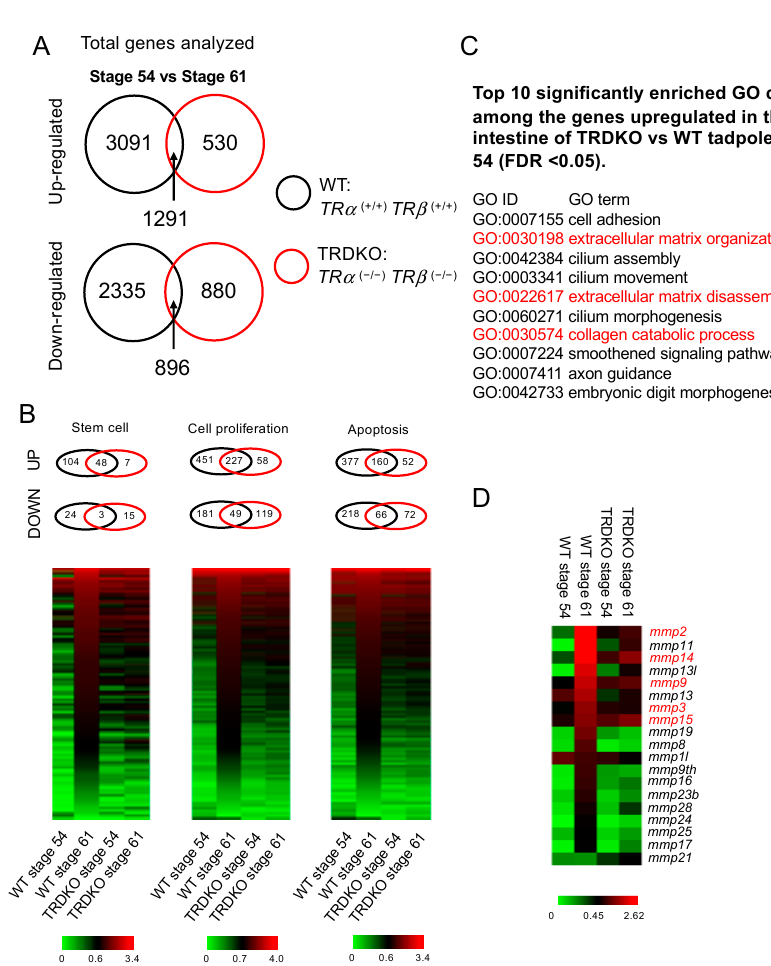
Figure 6. TR double knockout inhibits the upregulation of genes in the GO categories involved in major intestinal remodeling processes: stem cell, cell proliferation, and apoptosis, at stage 61 during metamorphosis, but derepresses genes in ECM remodeling at premetamorphic stage 54. ( A ) Venn diagram analysis of genes regulated during intestinal metamor- phosis in wild-type and TRDKO tadpoles shows that the vast majority of the regulated genes are different between the wild-type and TRDKO animals. RNA-seq was carried out on intestinal RNA from wild-type and TRDKO tadpoles at premetamorphic stage 54 and climax stage 61. Genes up- or down-regulated at stage 61 compared to stage 54 (2 folds or more) were identified for each genotype and compared. Note that there were much fewer genes regulated in the TRDKO animals. ( B ) Venn diagrams and heat maps reveal that TRDKO tadpoles have drastically reduced number of regulated genes at stage 61 in the three GO categories critical for intestinal remodeling: stem cell, cell proliferation, and apoptosis. Top: All genes in each of the three GO categories were identified from the up- and down-regulated genes in each genotype as found in (A) and compared by Venn diagram analysis between the two genotypes. Note that again most of the genes did not overlap between the two genotypes. Bottom: Heat maps of the expression of all genes in each GO category at the two stages for the two genotypes. Note the coordinated upregulation of most of the genes in each GO category at stage 61 compared to stage 54 in the wild-type intestine but not in the TRDKO intestine. ( C ) GO analysis reveals that GO categories related to ECM remodeling (shown in red) are significantly enriched among genes expressed at higher levels in the stage 54 intestine of TRDKO tadpoles compared to the wild-type ones. The RNA-seq data from (A) were used to identify genes that were expressed at higher levels (2-fold or more) in the stage 54 intestine of TRDKO tadpoles compared to the wild type ones. The 3187 genes thus identified were subjected to GO analysis, and the top 10 enriched GO terms are shown. ( D ) Heat maps of the expression of MMP genes at the two developmental stages (54, or premetamorphosis, and 61, or